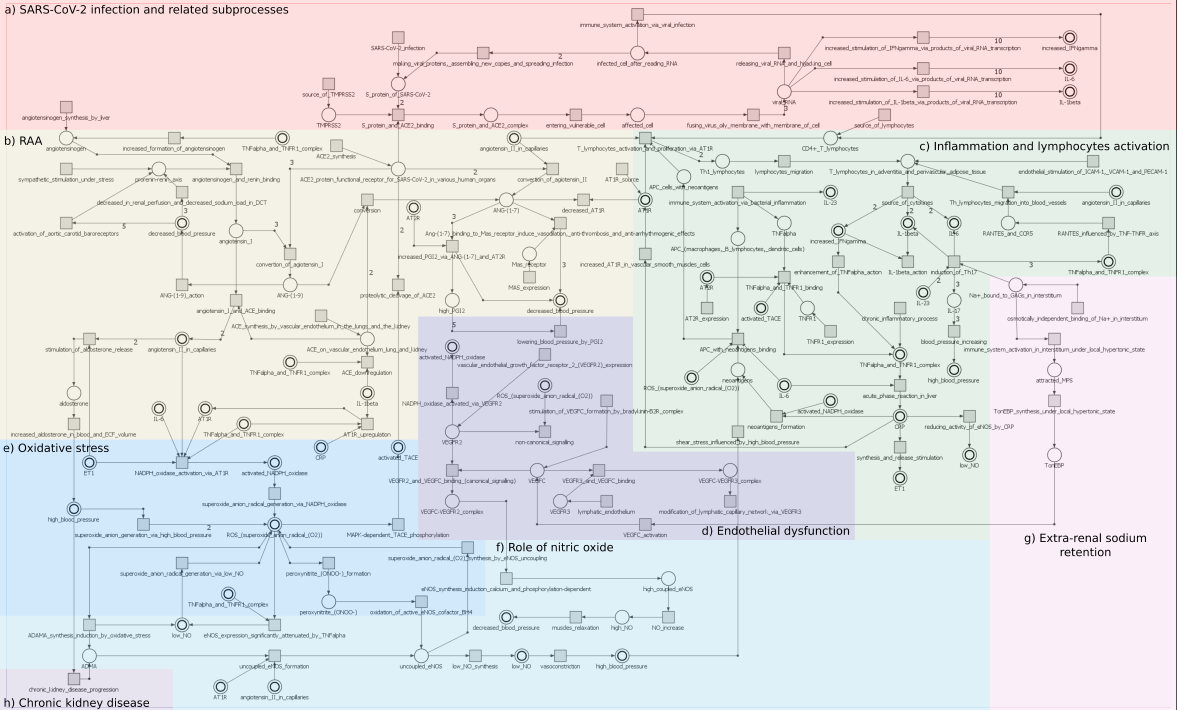
t 61 , t 64 , t 68 , t 76 , t 78 , t 84 , t 85 , t 86 ), which are marked in bold fonts in Tables 1 and